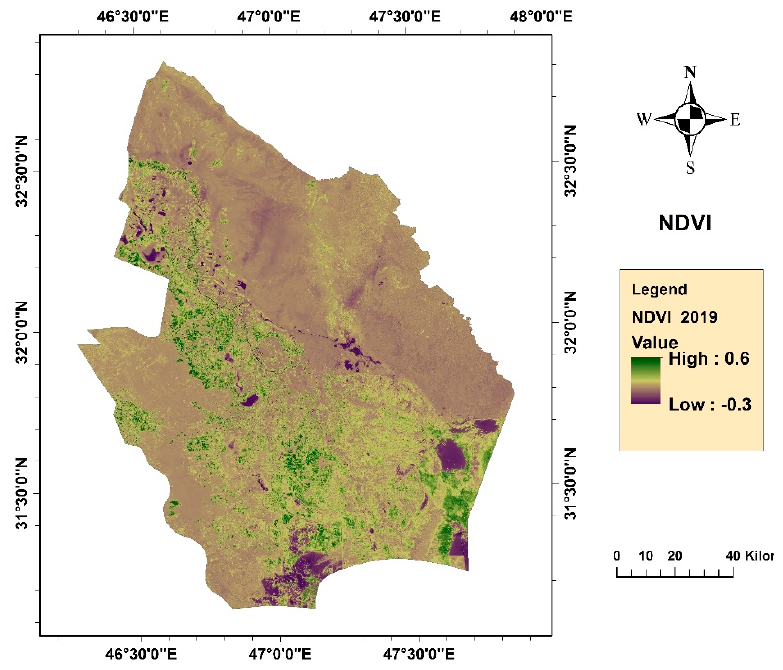
Figure 7. Normalized Difference Vegetation Index (NDVI) layer, based on Landsat 8 images.